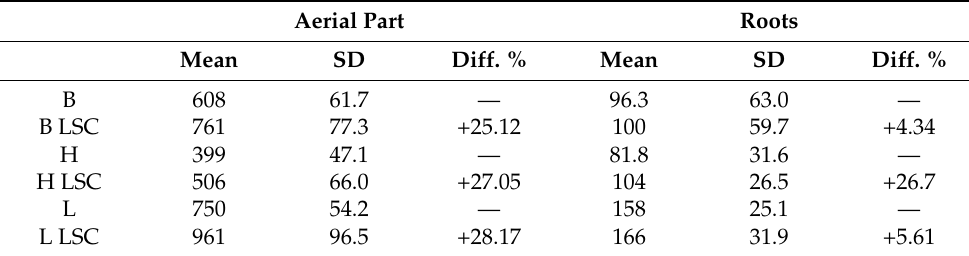
Table 3. Dry weight (mg) of the biomass of the aerial part and of the roots of plants. Values are reported as mean ± standard deviation